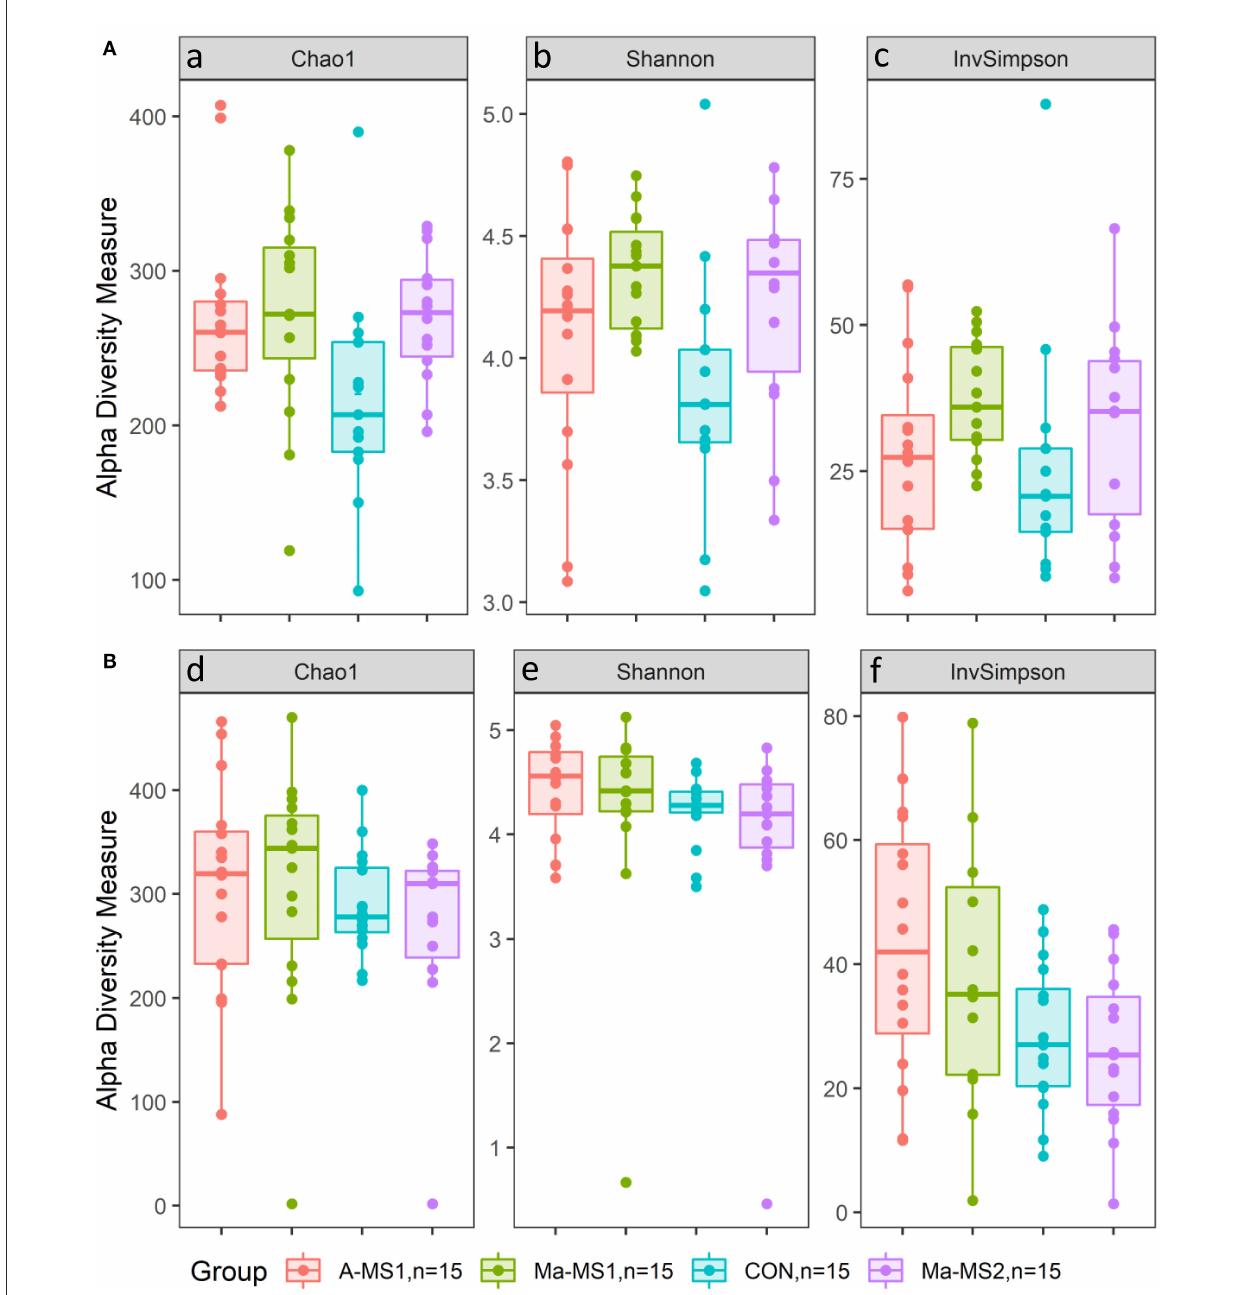
FIGURE2 Box plot of alpha diversity indices values according to the group. (A) d14; (B) d21; CON = control group without milk supplementation; A-MS1 = MS1, provided automatically; Ma-MS1 = MS1, provided manually twice a day; Ma-MS2 = MS2, provided manually twice a day. a CON vs. A-MS1, p = 0.05; CON vs. Ma-MS1, p = 0.02; CON vs. Ma-MS2, p = 0.09; CON vs. MS, p = 0.02; CON vs. A-MS1 + Ma-MS1, p = 0.02. b CON vs. Ma-MS1, p = 0.01; CON vs. Ma-MS2, p = 0.07; CON vs. MS, p = 0.03; CON vs. A-MS1 + Ma-MS1, p = 0.03. c CON vs. Ma-MS1, p = 0.10. d CON vs. A-MS1, p = 0.07; CON vs. A-MS1 + Ma-MS1, p = 0.06; Ma-MS2 vs. A-MS1 + Ma-MS1, p = 0.05. e CON vs. A-MS1, p = 0.08; CON vs. Ma-MS1, p = 0.09; CON vs. A-MS1 + Ma-MS1, p < 0.05; Ma-MS2 vs. A-MS1 + Ma-MS1, p = 0.053. f CON vs. A-MS1, p = 0.01; CON vs. Ma-MS1, p = 0.06; CON vs. MS, p = 0.07; CON vs. A-MS1 + Ma-MS1, p = 0.01; Ma-MS2 vs. A-MS1 + Ma-MS1, p = 0.01; Automatic vs. Manual, p =